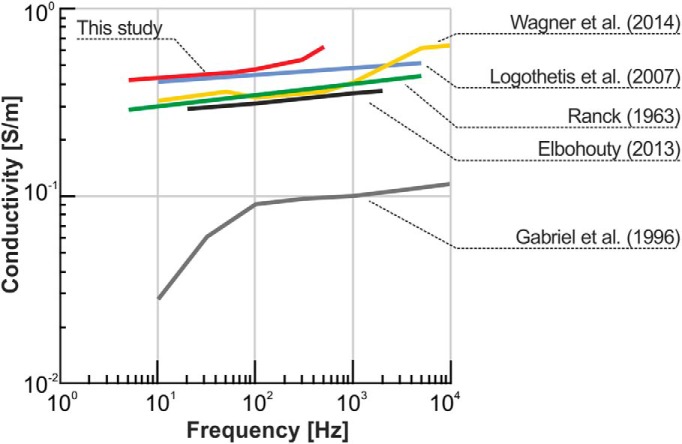
Literature review of reported conductivities in various species and experimental setups. Gabriel et al. (1996): data from bovine brains recorded with a two-electrode setup. Elbohouty (2013): data recorded in vitro in slices of mouse cerebral cortex with a two-electrode setup. Logothetis et al. (2007): data from monkey recorded with a four-electrode setup. The average conductivity value, 0.405 S/m, combined with the reported increase of ∼25%. Wagner et al. (2014): recordings from cat cerebral cortex with a two-electrode setup, which was similar to the setup used by Gabriel et al. (1996). Ranck (1963): data from rabbit brain.